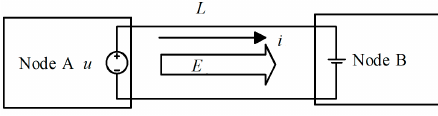
Figure 4. Energy transfer model.